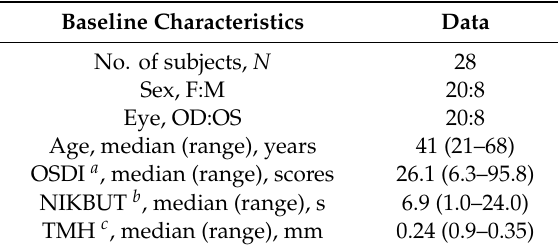
Table 1. Demographic data of